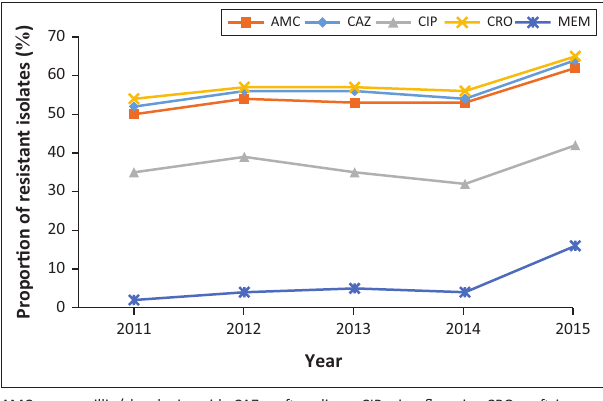
FIGURE 2: Resistance profile of K. pneumoniae (2011–2015).